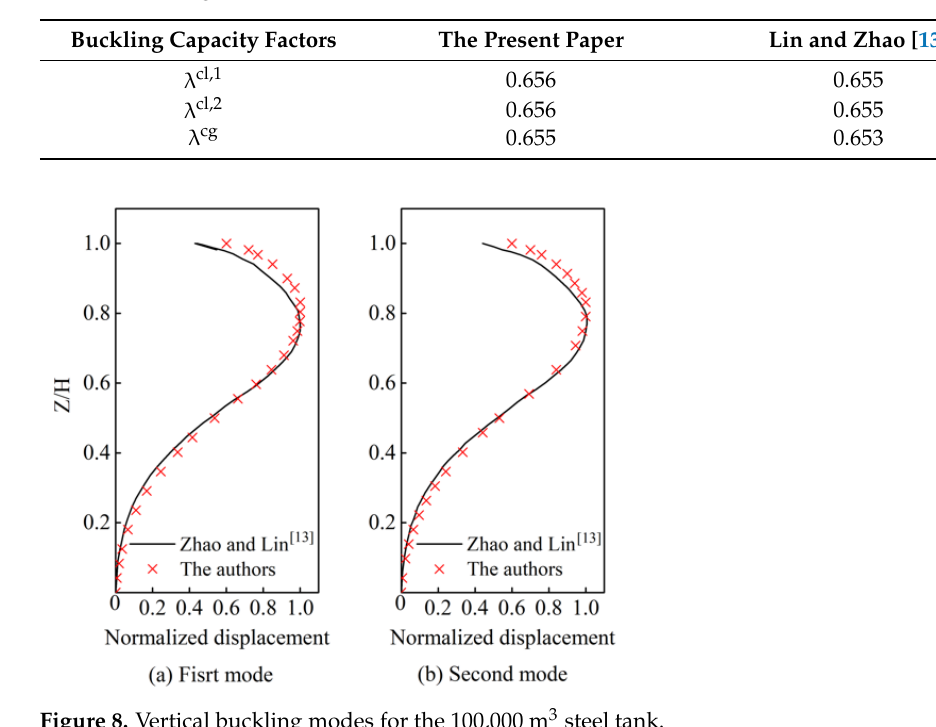
Figure 8. Vertical buckling modes for the 100,000 m 3 steel tank.